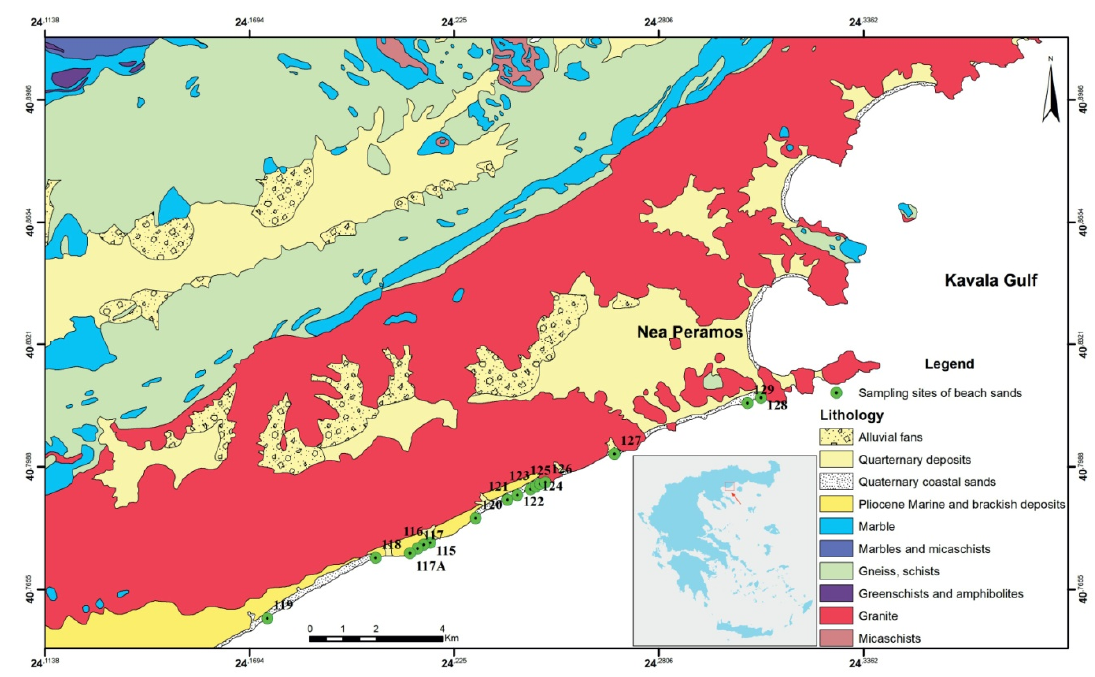
Figure 1. Geological map of the sampling area of Nea Peramos Loutra Eleftheron coast, Kavala region [12,13]. The large igneous body behind the coastline is Symvolon granite. Table 1. Common silicate, phosphate, and carbonate rare earth element (REE) bearing minerals in heavy mineral (HM) sands (bold, this study) and bauxite residues in Greece [6,9,14,24]. Data for mineral properties from [26] (and references therein) and apatite data from [30].